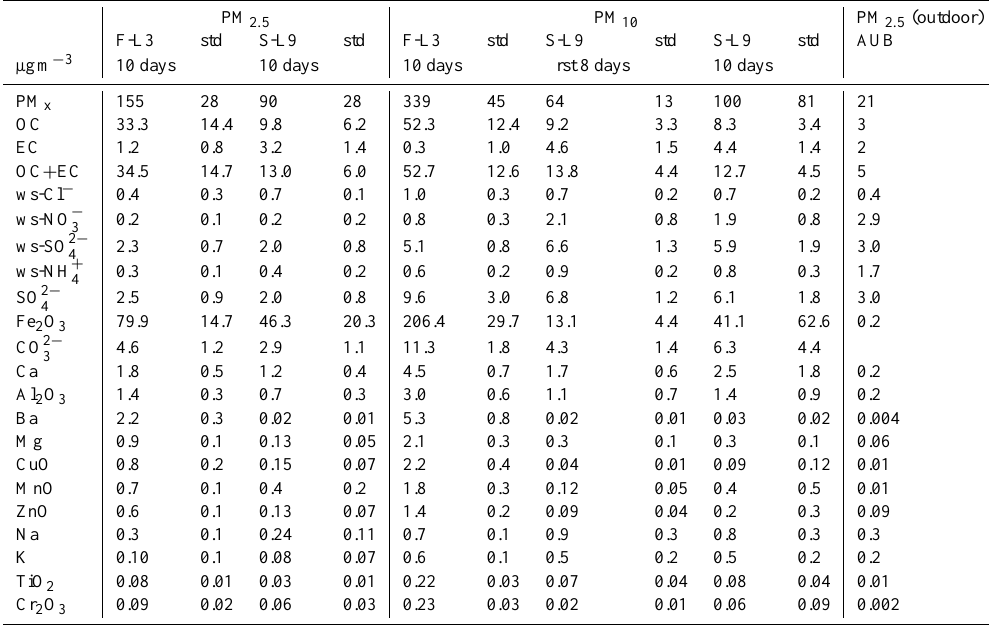
Table 4. Mean levels and standard deviation (std) of PM, and analyzed components in PM 10 and PM 2 . 5 at Fontana (L3) and Sagrera (L9) platform sites from 5 to 24 July 2011. ws, water soluble; SIA, secondary inorganic aerosols. Annual urban background (AUB) levels of PM 2 . 5 components reported for Barcelona by Pérez et al. (2008) are also shown for